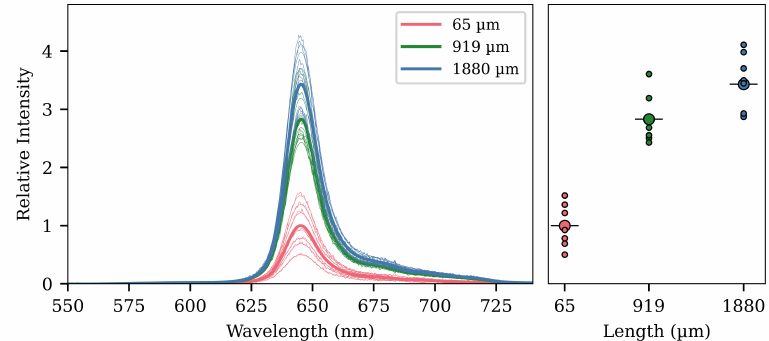
Figure 6. Results of varying the cavity lengths and with fixed depths at about 140µm. The signal increases rapidly from 65µm to 1mm, but slows between 1 and 2mm. The plot to the right shows the peak intensities of the spectra. The larger circle with the horizontal line through is the average for the batch, while the smaller circles are the individual fiber responses. The peak around 680nm is a result of defective